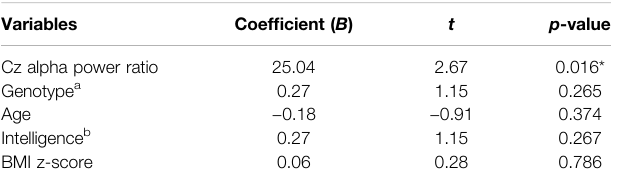
TABLE 3 | Multivariate stepwise linear regression analysis coef fi cients of the association between the commission error T-score and attention-to-resting Cz alpha power ratio.